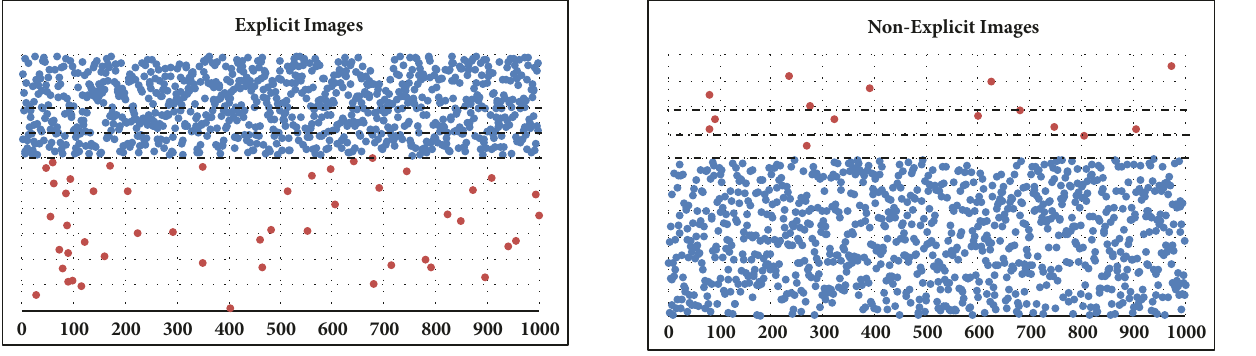
Figure 12: Result graph of application of the proposed ECD system on 1000 nonexplicit dataset